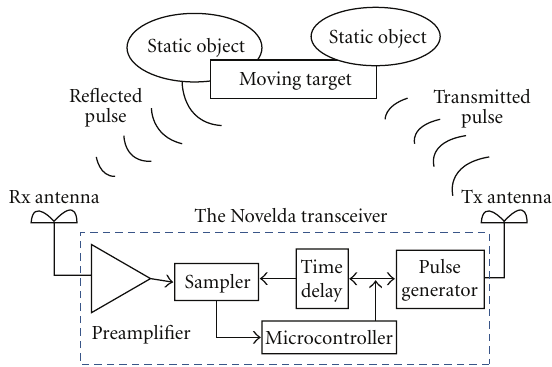
Figure 2: Presentation of the operating principle of the compact UWB radar